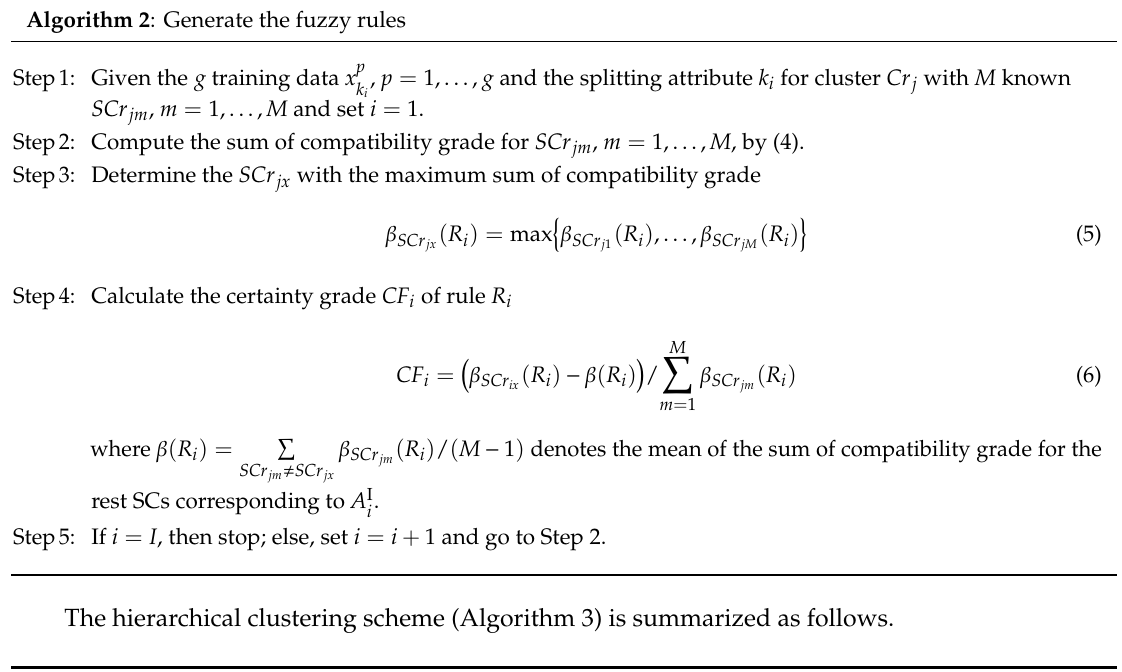
Algorithm 3 : Hierarchical clustering scheme